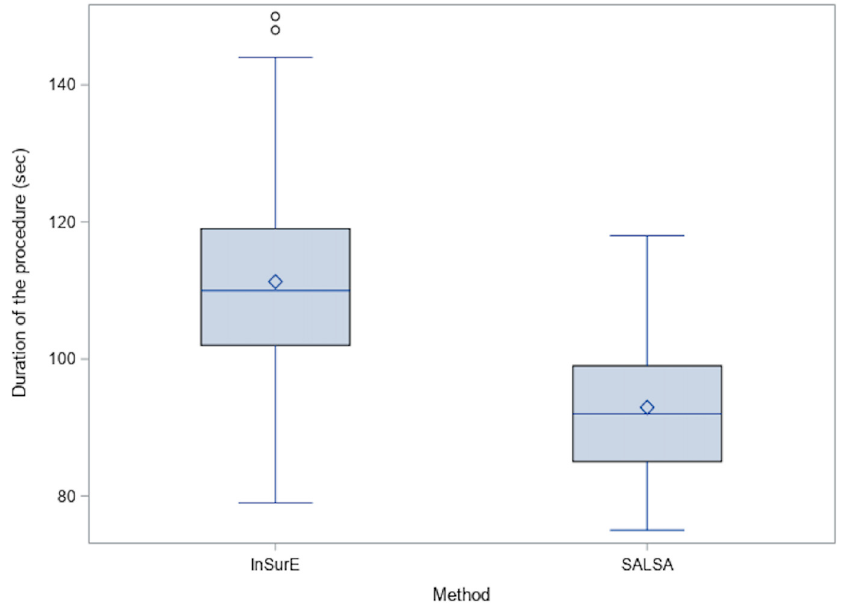
Figure 4. Duration of the procedure.